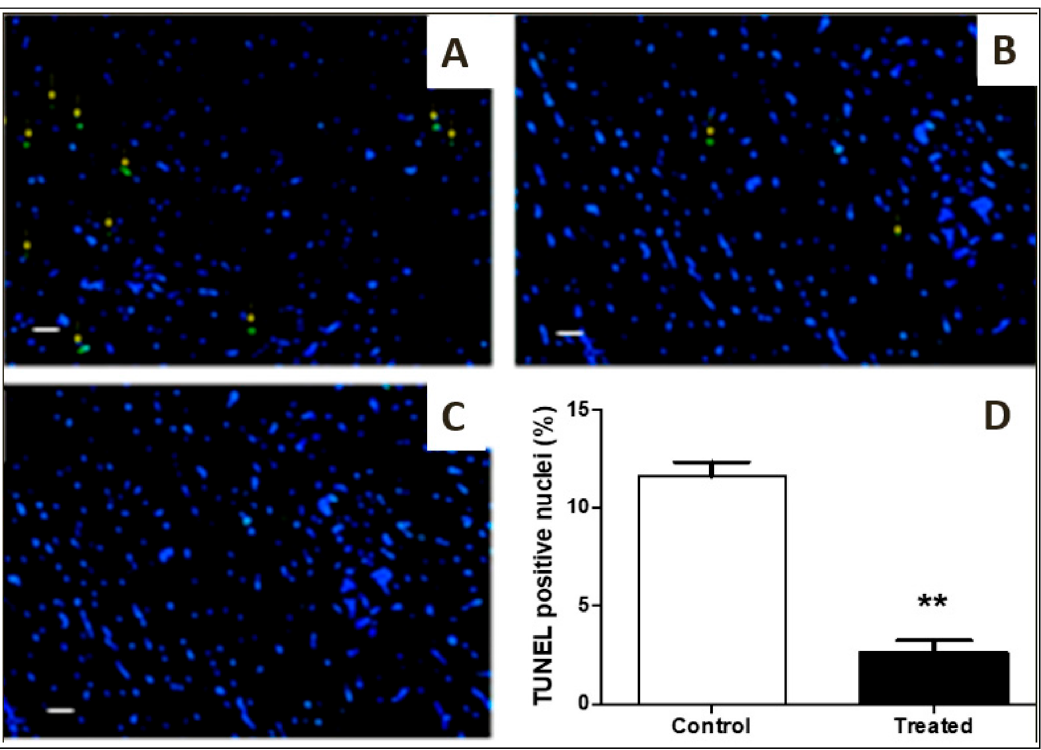
Figure 6. TUNEL Assay: ( A , B , C ): Representative images ( n = 10 for each group) immunofluorescent staining for TUNEL-positive nuclei in control, treated, and negative control groups (20 × magnification). TUNEL-positive myocytes were less in number in the treated group ( A ) as compared to control group ( B ). Yellow arrows indicate apoptotic nuclei and ( C ) negative control. p -value = 0.002 considered significant (** p < 0.001, control versus treated), scale bar is 100 µ m. ( D ): Graphical presentation of apoptotic nuclei in control vs treated